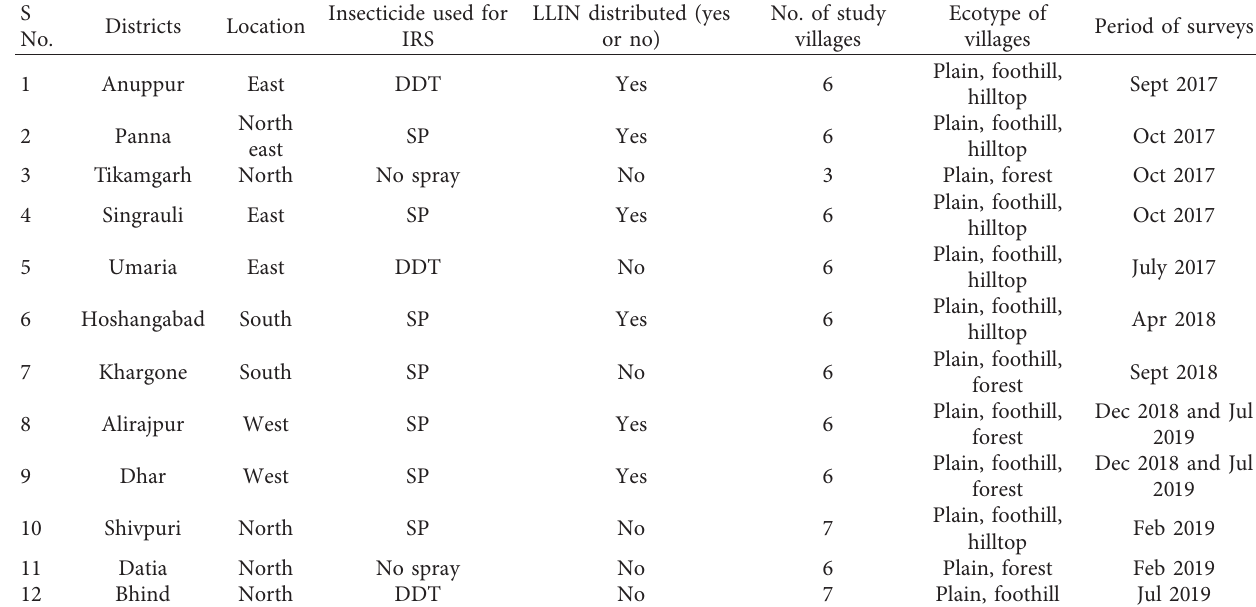
Table 2: Profile of study areas including the vector control measures and the period of